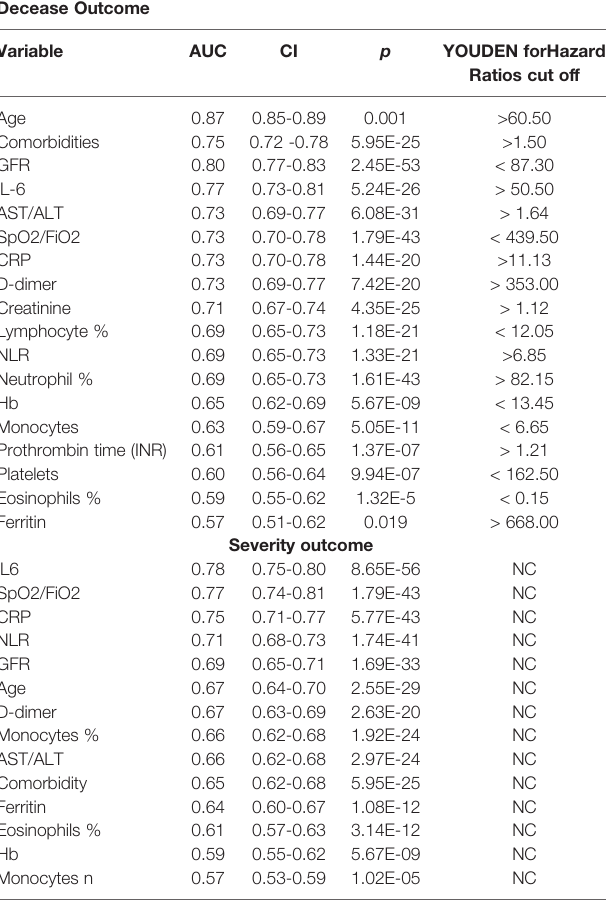
TABLE 5 | ROC curve analysis as for clinical laboratory test performance comparison for survival/decease and non-severe/severe outcomes. Decease